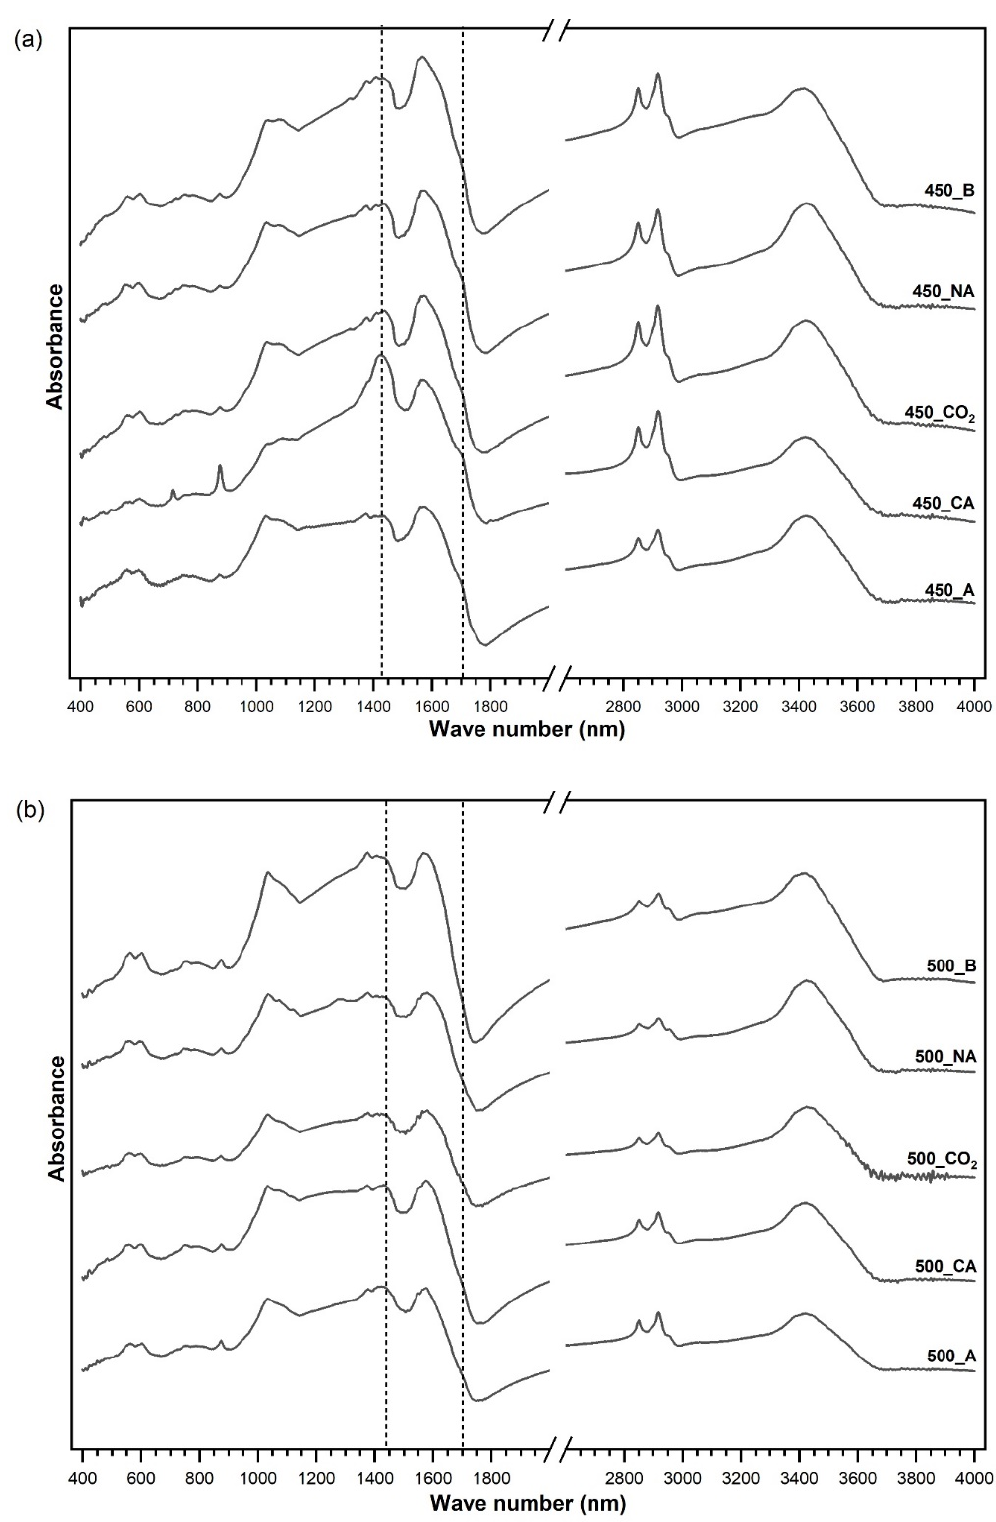
Figure 3. Fourier transform infrared (FT-IR) spectra of biochar pyrolyzed at 450 °C ( a ) and 500 °C ( b ).